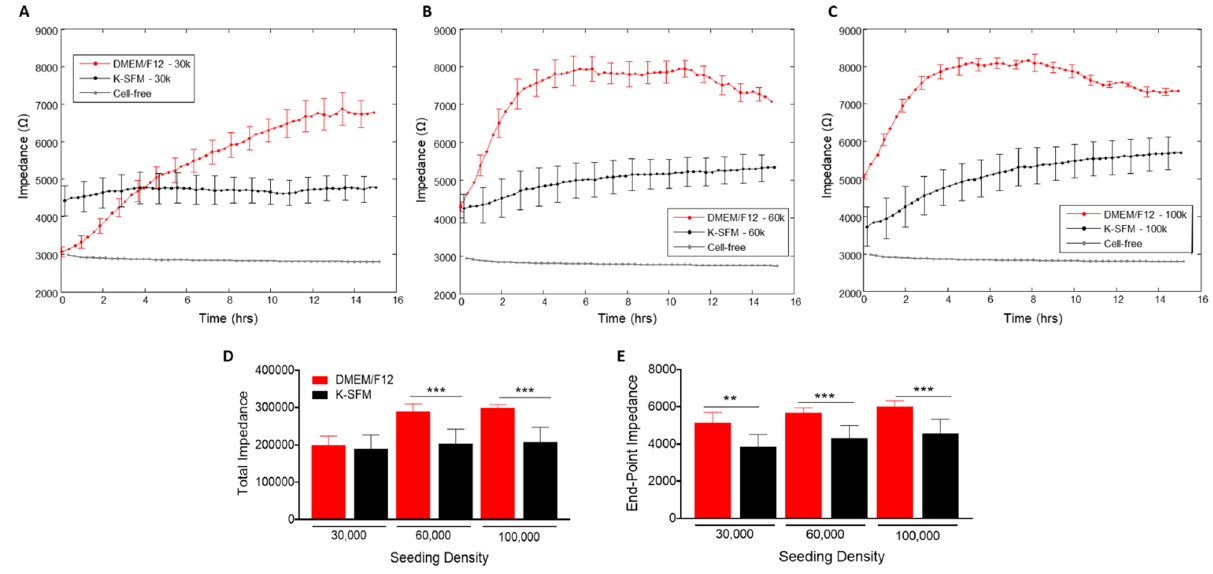
Figure 3. Real-time monitoring of HUCL impedance in DMEM/F12 versus K-SFM media. Impedance of HUCLs versus time, measured at an AC frequency of 32 kHz for 30,000 ( A ), 60,000 ( B ) and 100,000 ( C ) seeding densities is shown. Bar graph representation of total impedance ( D ) and end-point impedance ( E ) comparing DMEM/F12 versus K-SFM. Data shown are the mean ± SEM; n = 5/group. ** p ≤ 0.01 and *** p ≤ 0.001.